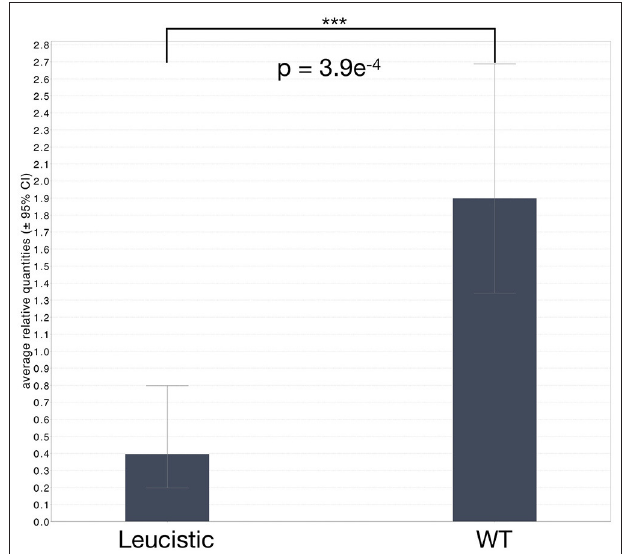
FIGURE 5 | Average relative levels of MITF expression in leucistic and non-leucistic individuals. Whiskers correspond to the ± 95% confidence interval. Statistical significance was assessed with a non-paired Mann-Whitney test and a two-sided significance; ***corresponds to P ≤